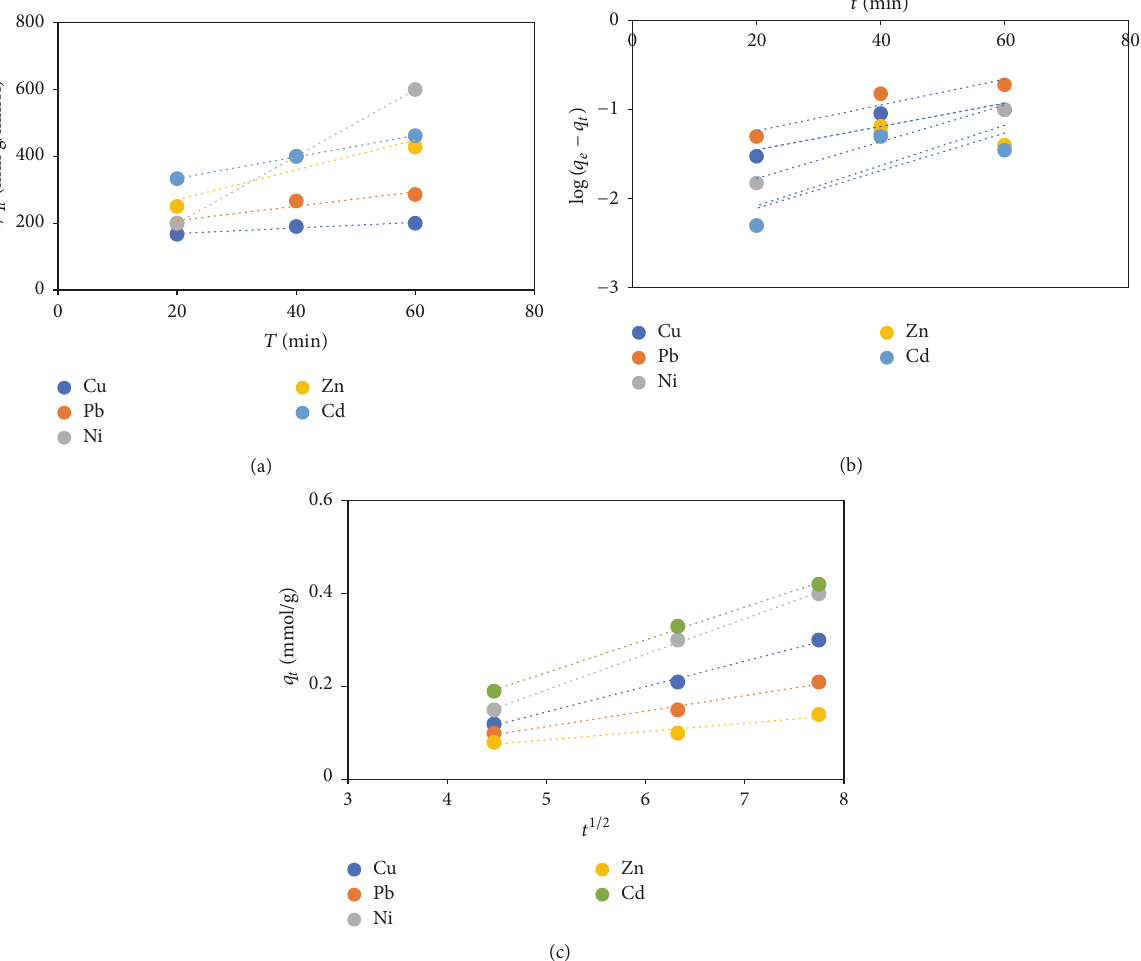
Figure 16: Pseudo-first-, pseudo-second-, and intraparticle diffusion plot,